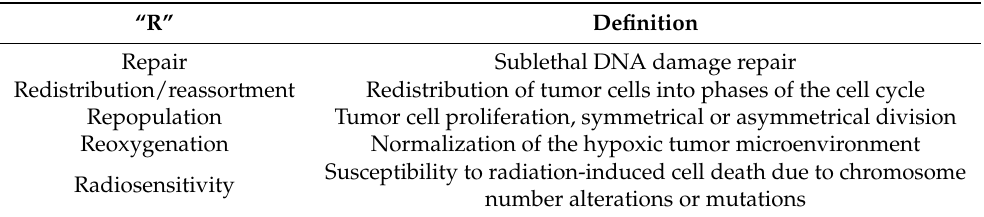
Table 3. The 4 R’s and the 5th